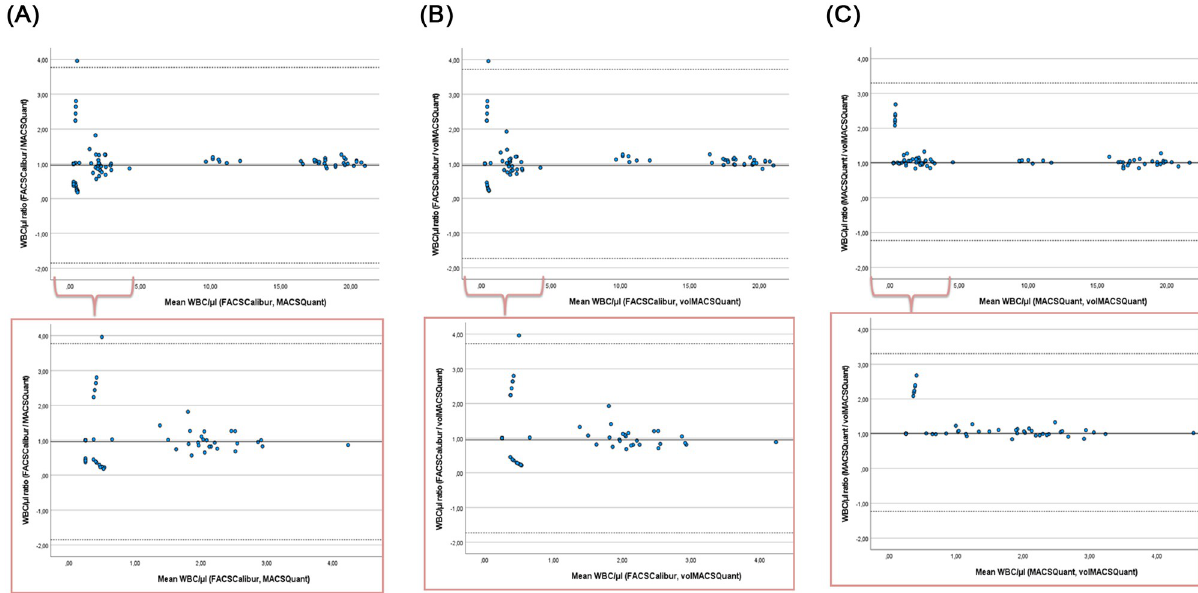
Fig 2. Bland-Altman analysis. Bland-Altman plots show the difference between the two paired measurements plotted against the mean of the two measurements. The events between 0 and 0.5 were considered as 0.25. As the differences were not normally distributed, a logarithmic transformation and back-transformation (antilog) were made. Y-axis: geometric means ratio of the leukocyte count in the controls and samples (n = 218) between the FACSCalibur bead-based method and the MACSQuant 10 bead-based method (A), between the FACSCalibur bead-based and the MACSQuant 10 volumetric method (B), and between the MACSQuant bead-based method and the MACSQuant volumetric method (C). The ratio was 0.96 with 95% limits of agreement -1.85 to 3.77 for A, 0.99 with 95% limits of agreement -1.73 to 3.72 for B, and 1.03 with 95% limits of agreement -1.24 to 3.30 for C. 95% limits of agreement was defined as bias ± 1.96 standard deviation of the difference. X-axis: the mean of WBC/ μ l for the same pairs of methods, respectively. Legend: bold line = ratio, doted lines = 95% limits of